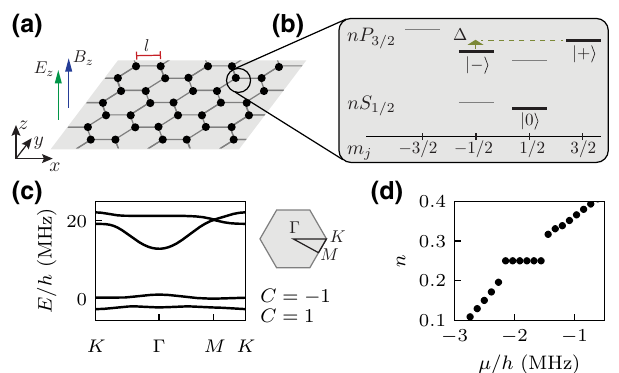
FIG. 1. The setup for the realization of a fractional Chern insu- lator. (a) Rydberg atoms are arranged in a honeycomb lattice with lattice spacing l . A homogeneous electric field E z and magnetic field B z are applied perpendicular to the plane of atoms, along the quantization axis z . (b) The fields isolate the Rydberg levels of the V -structure | 0 (cid:2) , |+(cid:2) , and |−(cid:2) (black lines). The state | 0 (cid:2) is treated as the vacuum state and the excitations |±(cid:2) as particles. The energy difference (cid:3) = E + − E − between |+(cid:2) and |−(cid:2) is con- trolled by the fields. (c) The single-particle band structure along the depicted path through the Brillouin zone for the experimental parameters that are given in the main text ( h is Planck’s